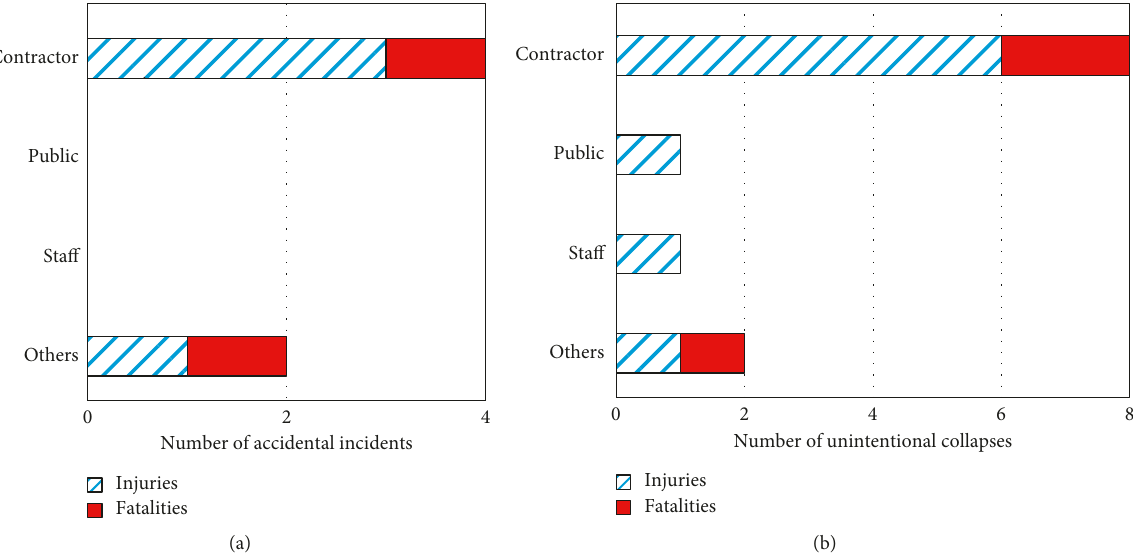
Figure 2: Number of (a) accidental incidents and (b) unintentional collapses caused injuries and